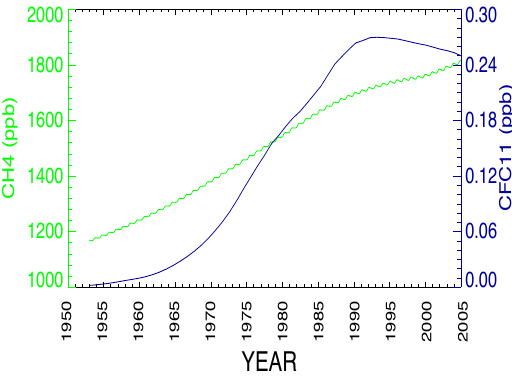
Figure 1. Model forcings. Concentrations of CH 4 (green, left axis) and CFC-11 (blue, right axis) globally area-averaged at the lower boundary and used to force the WACCM3.5